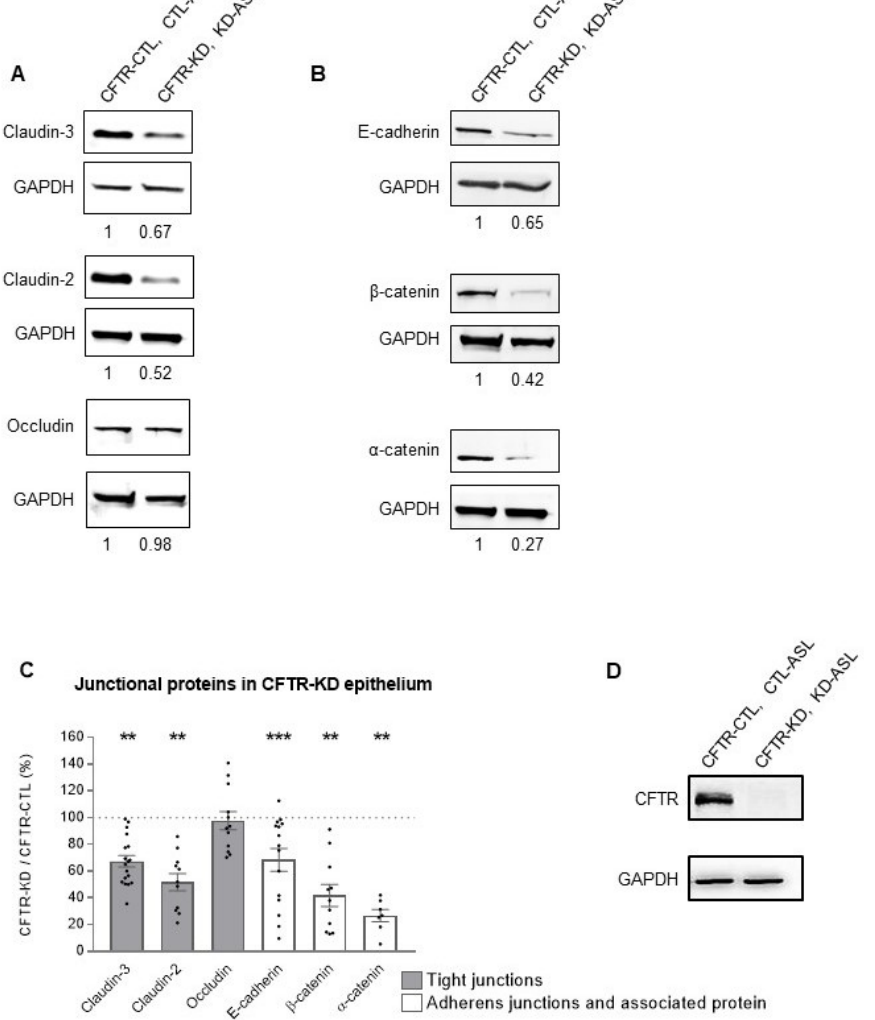
Figure 3. Altered expression of junctional proteins in the CFTR-KD epithelium. Junctional protein expressions were evaluated by Western blot. Representative Western blots for tight-junction ( A ) and adherens-junction ( B ) proteins. The relative expression level is indicated below each lane. ( C ) Quantification of protein expression in the CFTR-KD epithelia relative to their expression in the CFTR-CTL cells (dotted line). **, *** indicate the degree of significance, paired Student tests, N ≥ 7, n ≥ 1. ( D ) Western blot confirming the CFTR protein knockdown in the CFTR-KD cell compared to the CFTR-CTL cells.